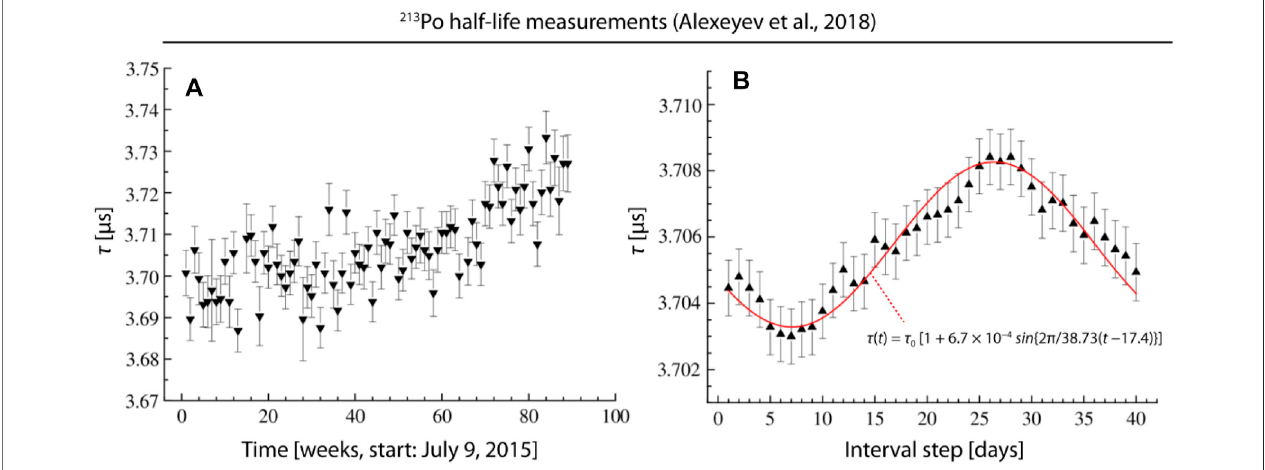
FIGURE5| 213 Pohalf-lifemeasurementsat BNO. (A) Time-dependenceofhalf-lifevaluesof 213 Po.Weeklydata. (B) Detectionofanoscillationinthe 213 Pohalf-life data with a period of 9.43 year − 1 (period of 38.73 days) using the method of interior moving average with a one-day step. Reprinted with modi fi cations from Alexeyev et al. [17] (picture obtained from the arXiv version of the article, arXiv:1806.01152).